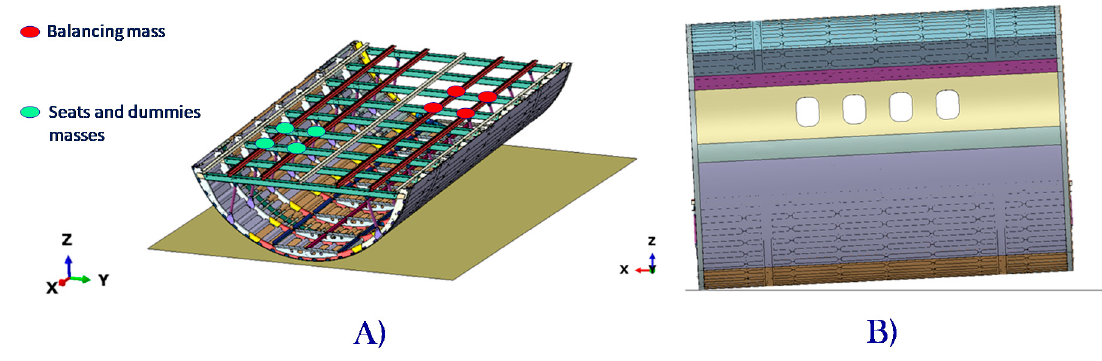
Figure 5. Added masses and relative positions. ( A ) Passenger floor isometric view. ( B ) Lateral view.